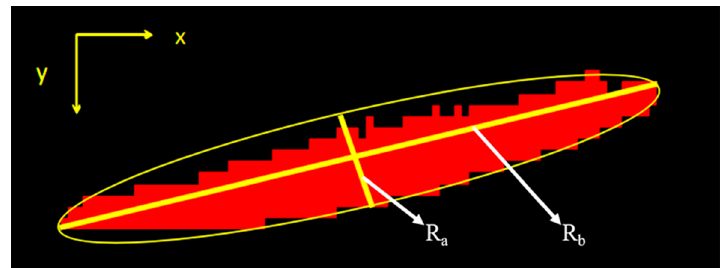
Figure 10. External ellipse.